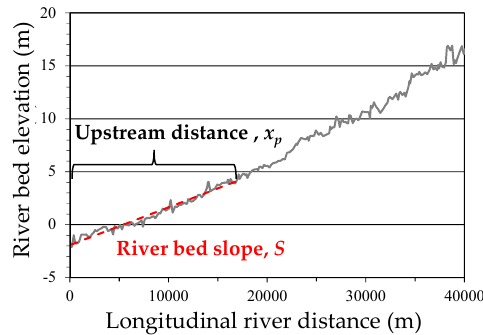
Figure 2. An example data of riverbed elevation in the Naruse River, Miyagi Prefecture.